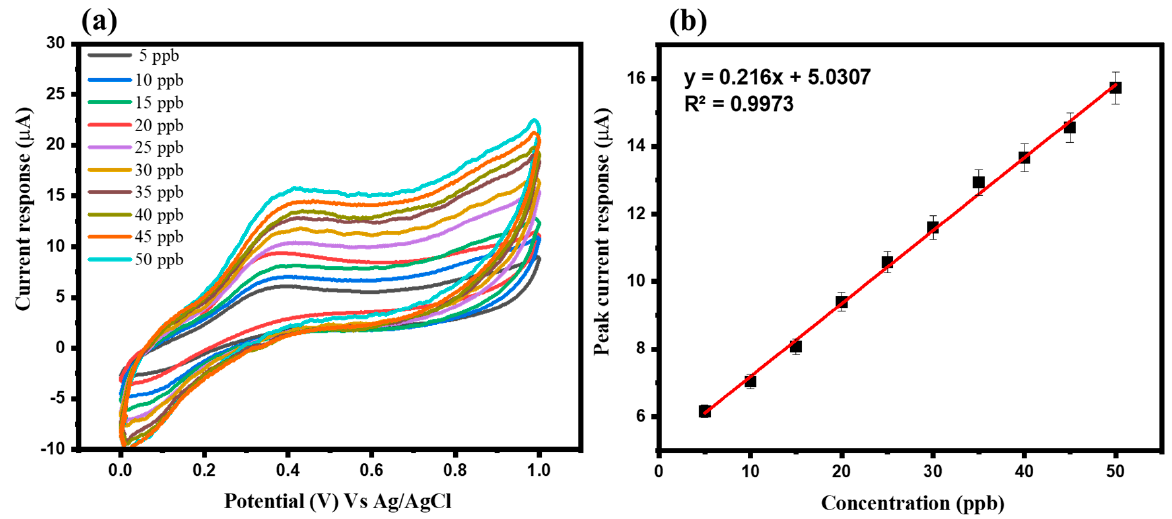
Figure 5. ( a ) CV response and ( b ) calibration plot of the NiO-GE with respect to concentration of As 3+ (0.1 M PBS of pH = 6) at scan rate = 50 mVs − 1 . As 3+ (0.1 M PBS of pH = 6) at scan rate = 50 mVs − 1